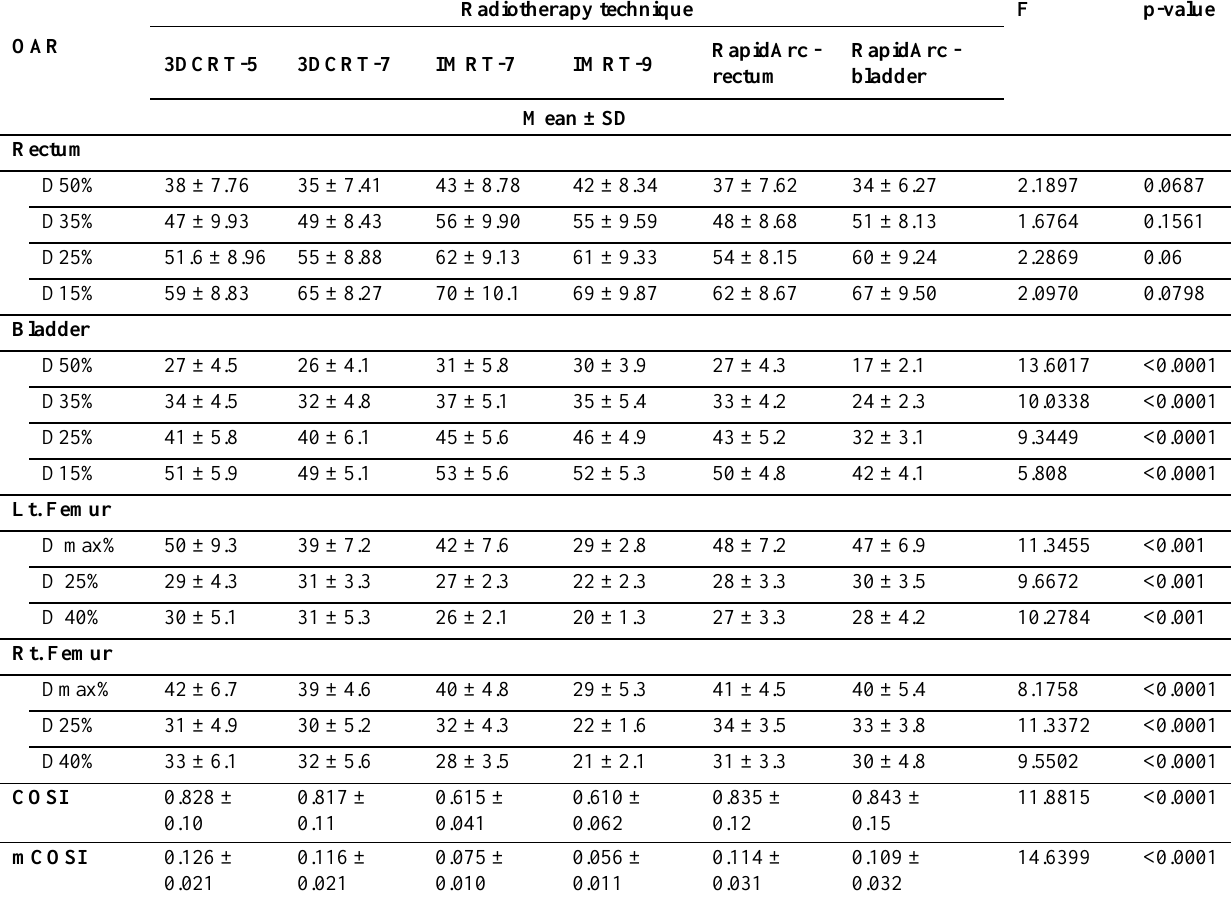
Table 2: Doses to organs at risk using the six radiotherapy techniques OAR